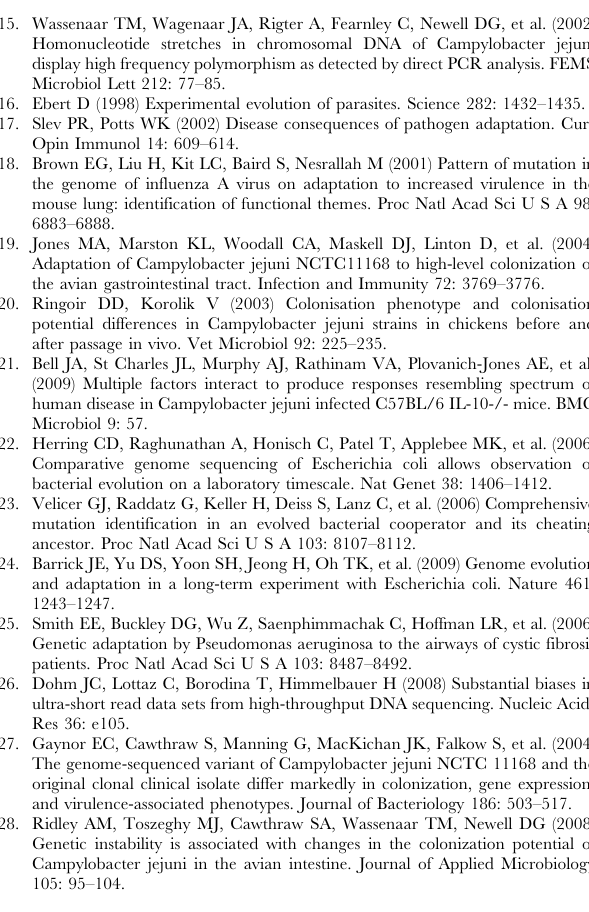
Table S3 Distribution of homopolymeric tract lengths. The number of Illumina re-sequencing reads containing specific homopolymeric tract length distributions at each contingency locus. The tract lengths that yield the in-frame ORF, and the percent of in-frame and frameshifted lengths for each locus before and after passage are also listed. Table S4 Primers used for real-time